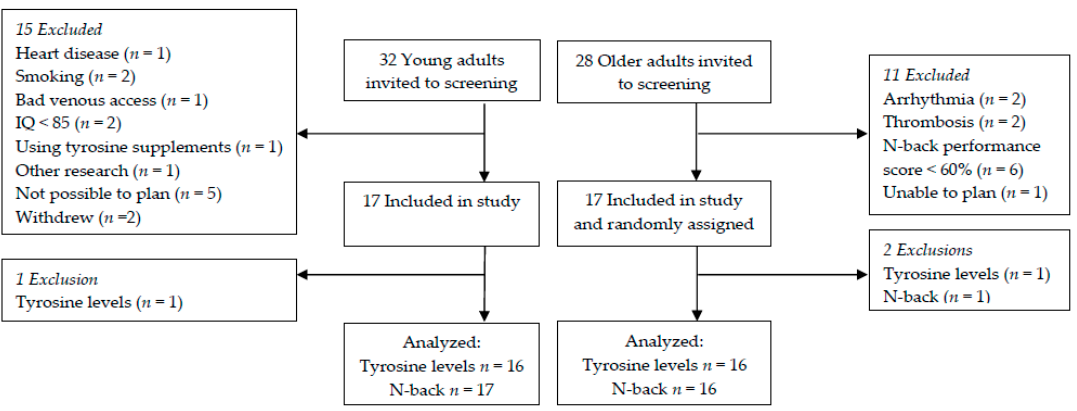
Figure 3. Flowchart of participants through the study. Abbreviation: IQ, Intelligence Quotient. Table 1. Characteristics at screening of 17 young and 17 older adults assigned into the study.